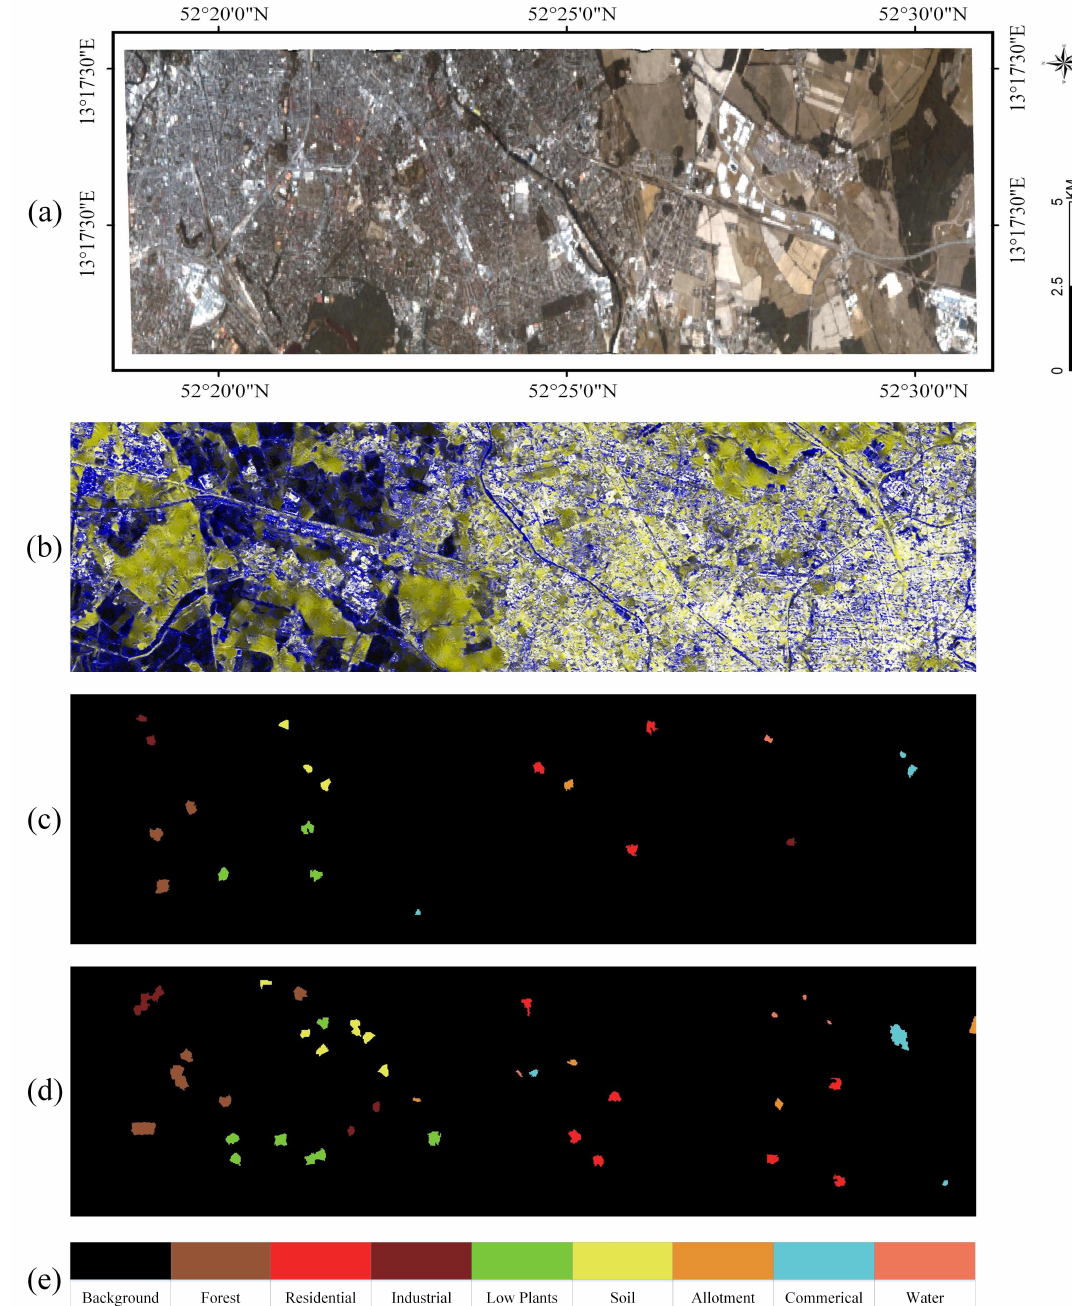
Figure 3. Berlin dataset. ( a ) False color image of HSI (No. 30, 20, and 10). ( b ) Synthetic aperture radar (SAR). ( c ) Training image. ( d ) Testing image. ( e ) Class